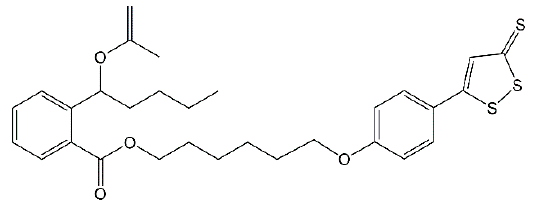
Figure 1. Chemical structure of 8e .